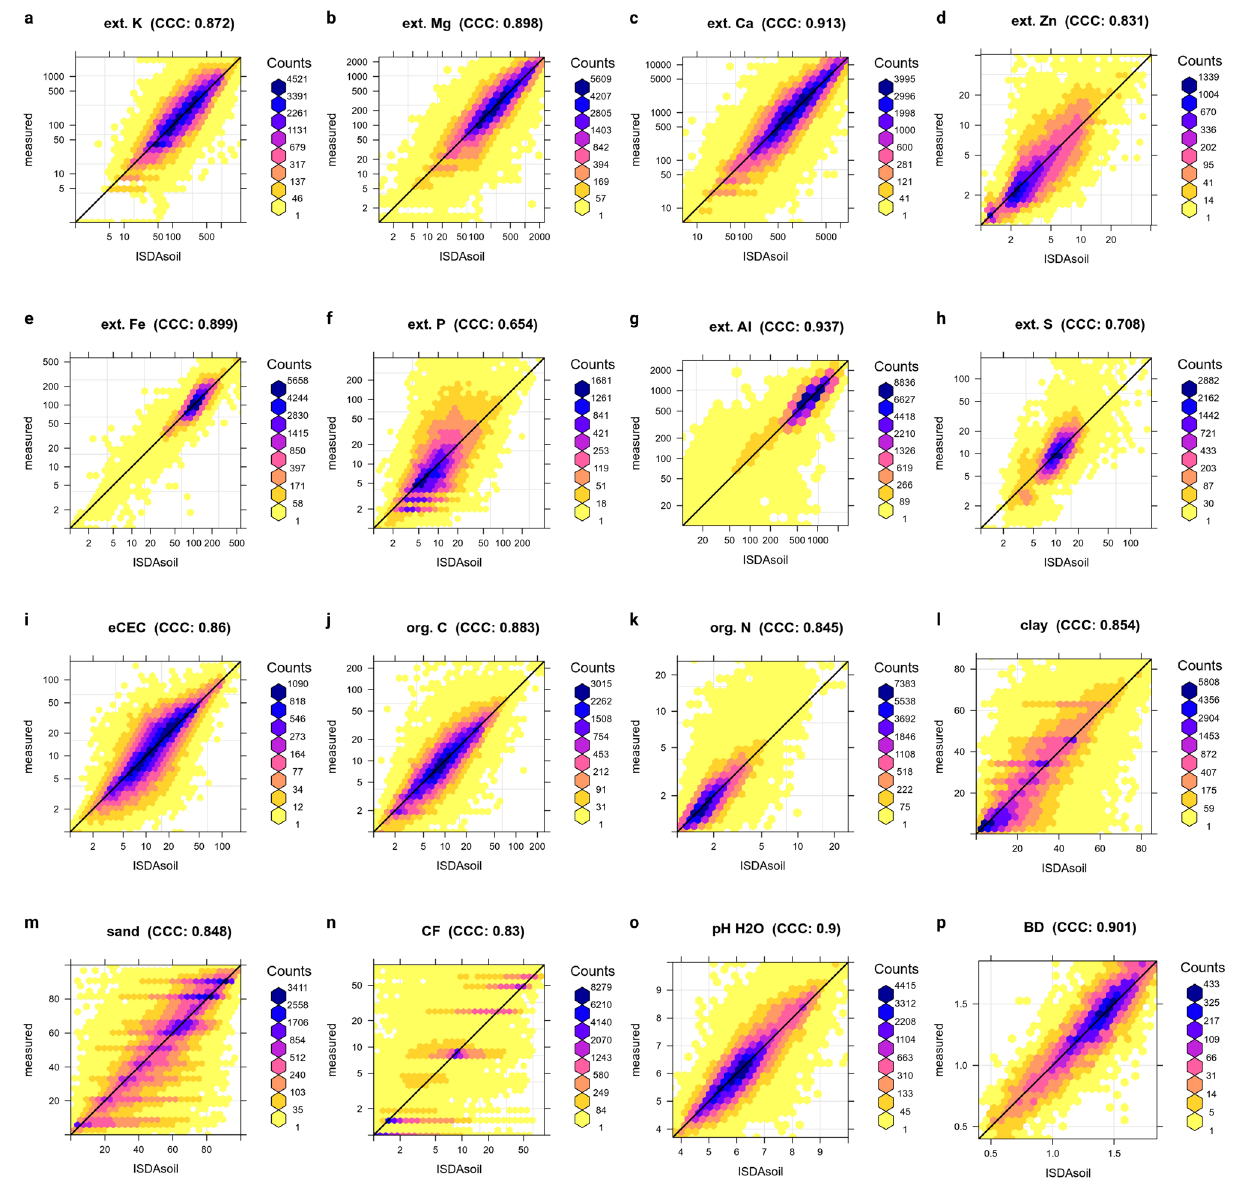
Figure 4. Accuracy assessment plots for all soil nutrients ( a – h ) and physical and chemical soil properties ( i – p ) based on the final models used for prediction. Accuracy plots derived using fivefold spatial cross-validation. Extractable nutrient concentrations expressed in mg/kg and displayed on a log-scale. CF Coarse fragments or stone content, BD bulk